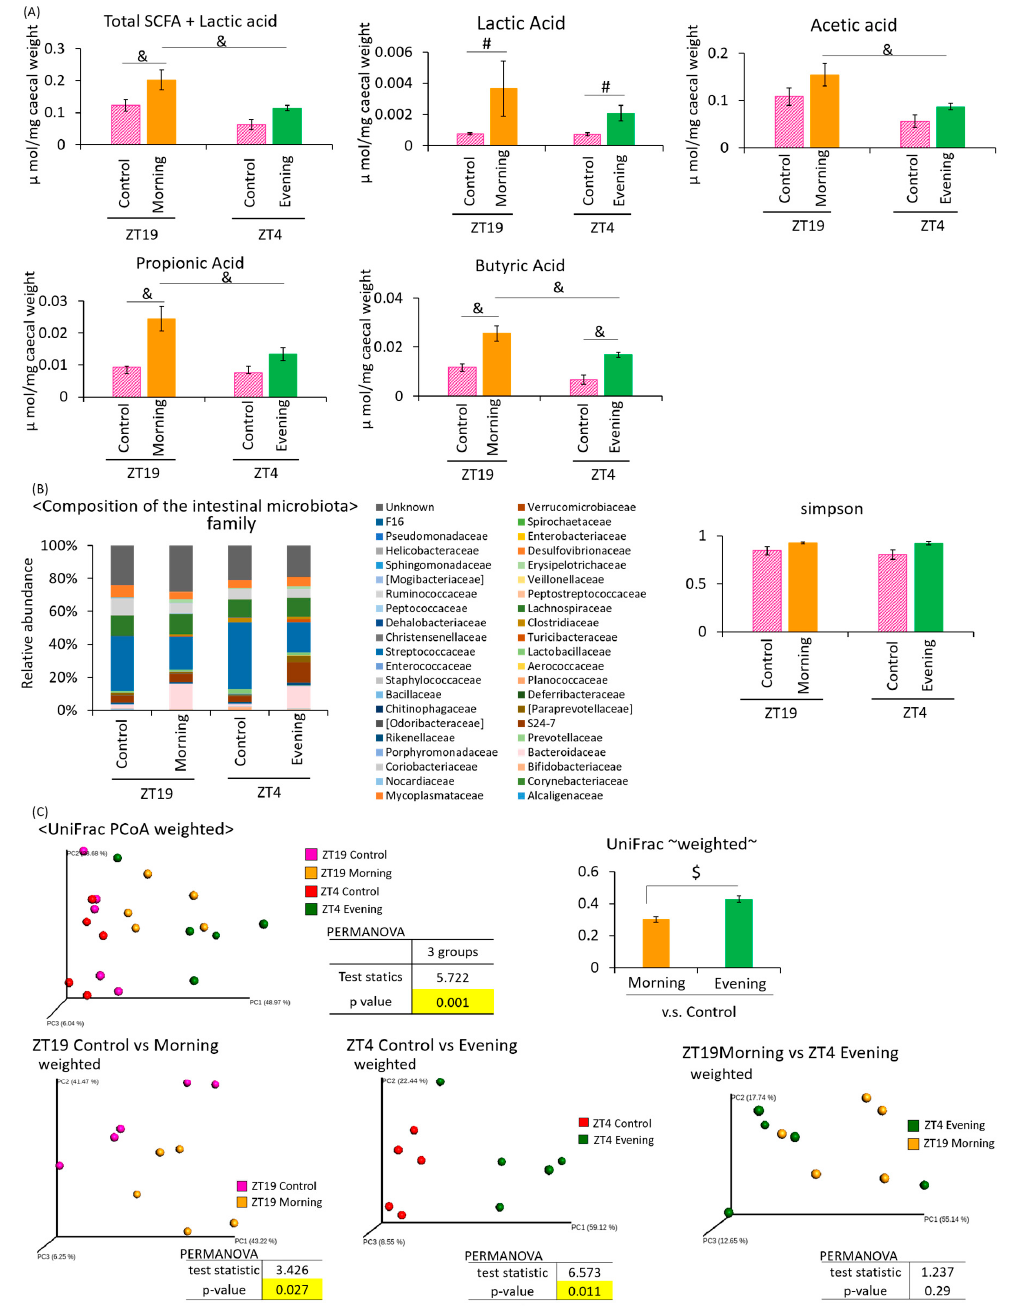
Figure 4. E ff ect of A. lappa intake in the morning or evening on caecal SCFAs and feces microbiota in mice with HFD. E ff ect of the A. lappa intake timing, morning or evening, on the intestinal microbiota. ( A ) SCFA component and lactic acid were measured from caecal contents by GC-FID. ( B ) Composition of the intestinal microbiota and α -diversity. ( C ) UniFrac PCoA weighted of intestinal microbiota. All data are represented as mean ± SEM ( n = 5 for each group). # p < 0.05, evaluated using the Mann–Whitney test with Dunn’s post-hoc analysis and a two-stage linear step-up procedure of the Benjamini, Krieger, and Yekutieli test for multiple comparisons. & p < 0.05, evaluated using the two-way ANOVA with Tukey post-hoc test. $ p < 0.05, evaluated using the t-test. Morning group took A. lappa during ZT12–ZT15 and was sacrificed at ZT19. Evening group took A. lappa during ZT21–ZT24 and was sacrificed at